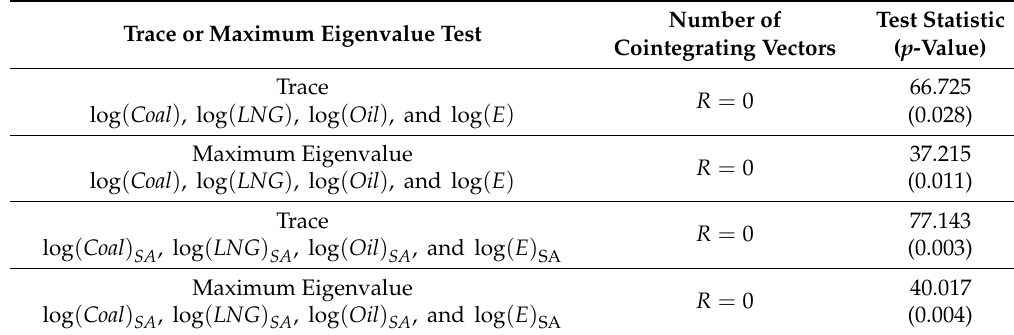
Table 4. Johansen Trace and Maximum Eigenvalue tests of cointegrating